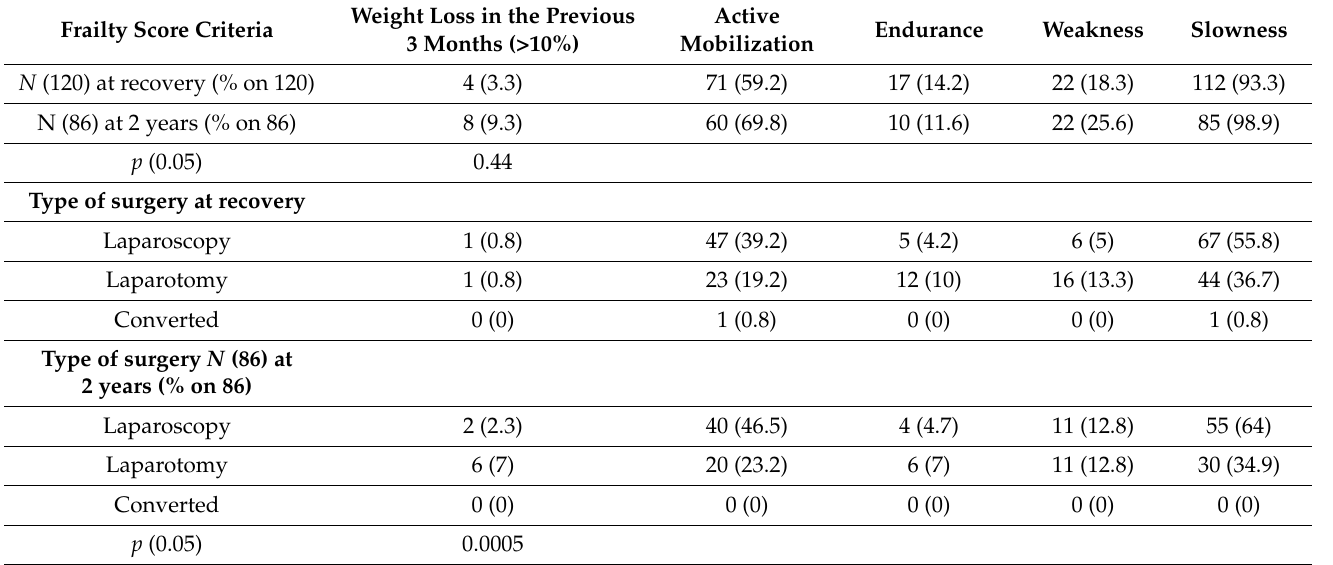
Table 8. Frailty score criteria at recovery ( N 120 and % on 120), at 2 years ( N 86 and % on 86), type of surgery at recovery ( N 120 and % on 120), at 2 years ( N 86 and % on 86) and p (0.05).